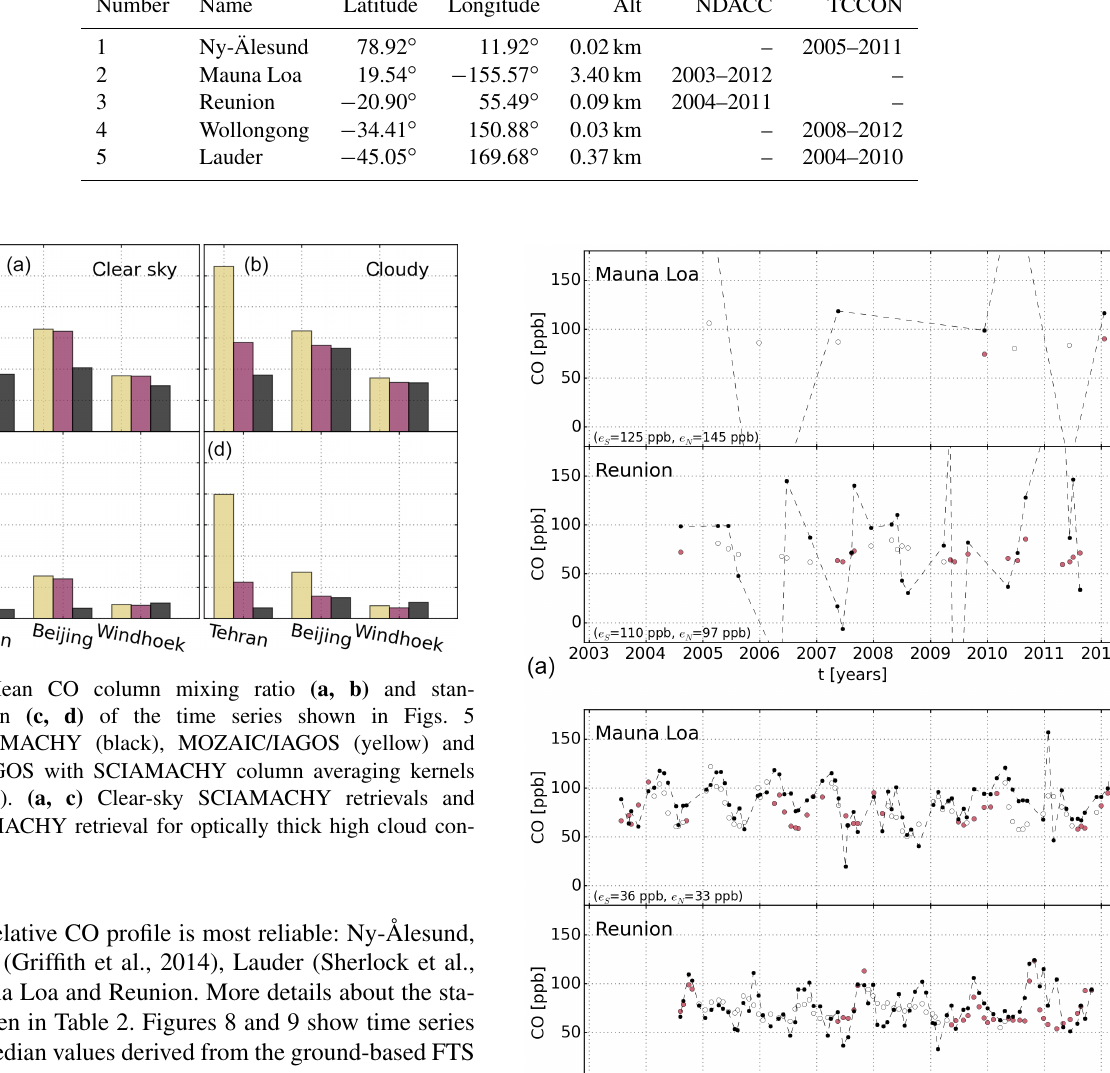
percentile (cid:15) S and is taken to be an analogue for the standard deviation of a normal distribution. Further, (cid:15) N is the mean re- trieval noise of the single measurements of the monthly me-